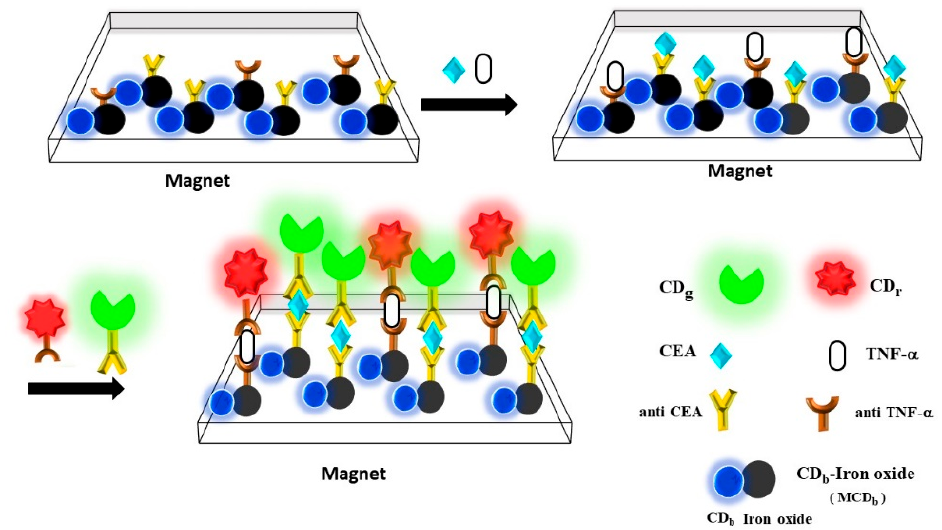
Figure 1. Schematic representation of the magnetic fluorescence-linked immunoassay with magnetofluorescent and fluorescent nanoparticles for the detection of CEA and TNF- α .